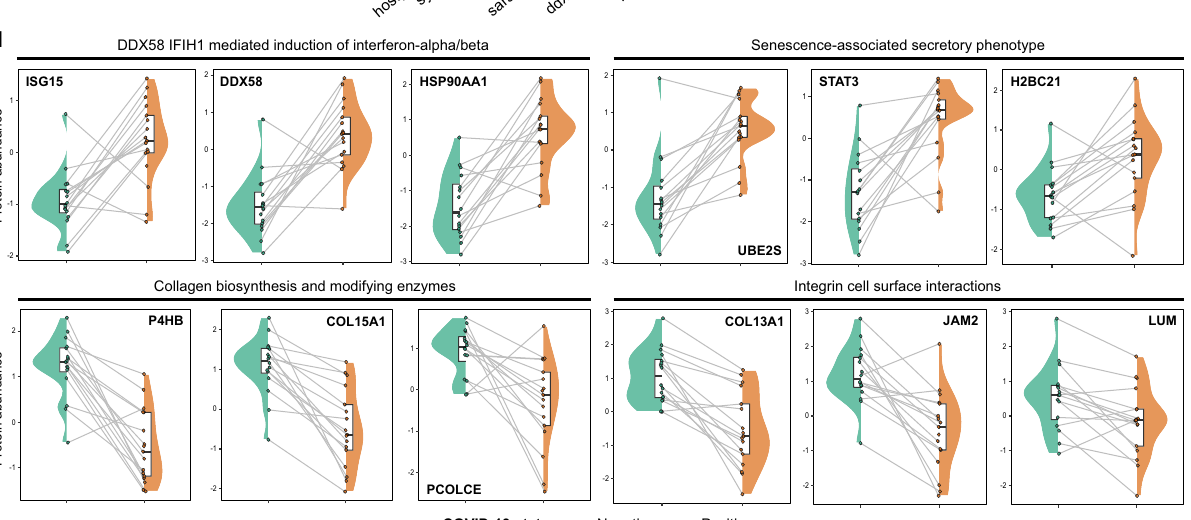
both cohorts. Genes are grouped by membership to pathways that were sig- ni fi cantly enriched (1% FDR) in GSVA. c The 30 protein pathway enrichment terms withthegreatestRRAscores(indicatingconsistentdysregulationinboththeWave 1and Wave 2proteomicdatasets),ordered byeffectsize.Allpathwaytermsshown were signi fi cantly enriched in the individual cohort analyses (1% FDR). Red= up- regulated in COVID-19 positive versus negative; blue= down-regulated. d As for b , but displaying selected plasma proteins (signi fi cant at 1% FDR) ( n =32 samples from 16